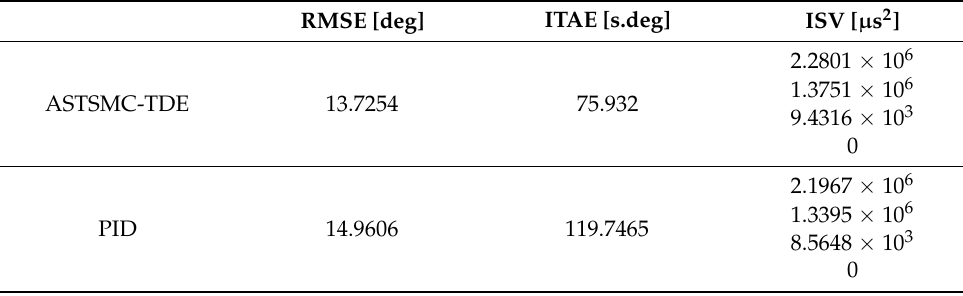
Table 5. RMSE, ITAE, and ISV values in experimental AM